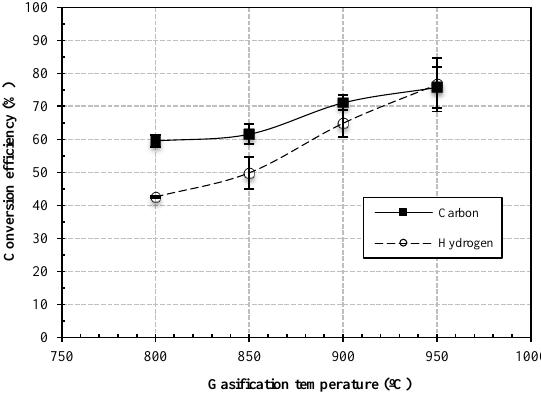
Figure 3. Effect of gasification temperature on carbon and hydrogen conversion efficiencies.